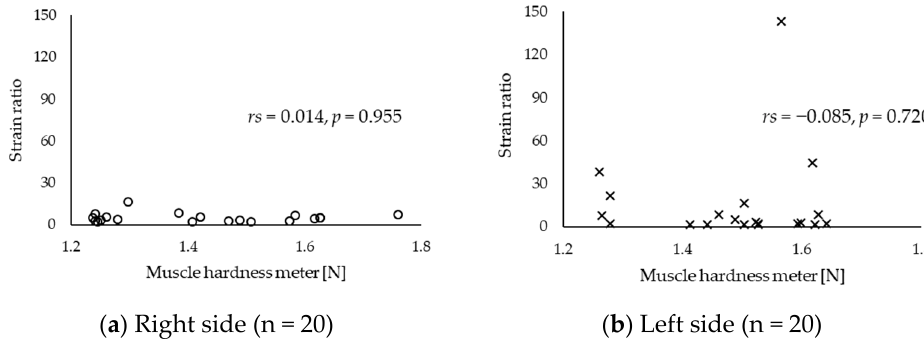
Figure 3. Scatter diagram between muscle hardness value assessed with a muscle hardness meter and that evaluated with strain ratio: ( a ) right side and ( b ) left side.